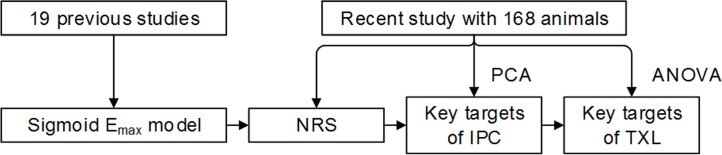
Data sources.Data from our 19 previous studies were used for mathematical modeling only. Data from our present experiment were used for calculating NRS and investigating mechanism of IPC and TXL. Abbreviations: NRS = necrosis reduction space; IPC = ischemia preconditioning; PCA = principal component analysis.